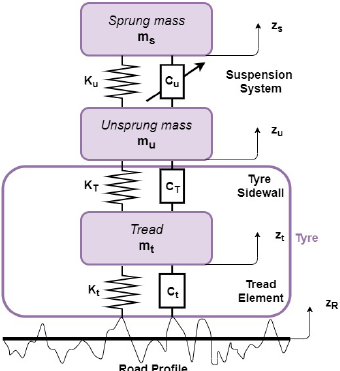
Figure 2. Quarter car